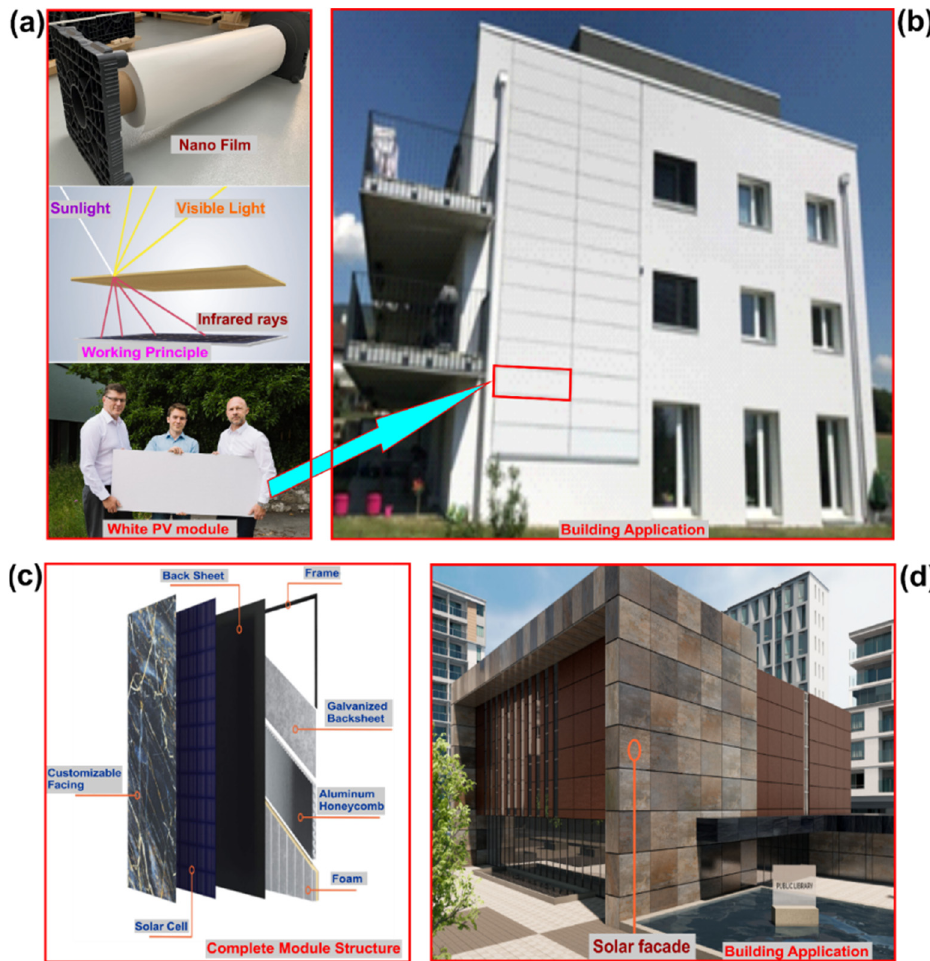
Figure 11. White appearance BIPV products based on using solar fi ltering. ( a ) white appearance nano fi lm, working mechanism, and PV module of CSEM technology, ( b ) White BIPV product integrated into a building (reproduced and modi fi ed with permission from Refs. [101,102] ), ( c ) Mitrex solar façade layers (reproduced and modi fi ed from [103]), and ( d ) Application of Mitrex solar façade in building (reproduced and modi fi ed with permission from Ref. [104] ).